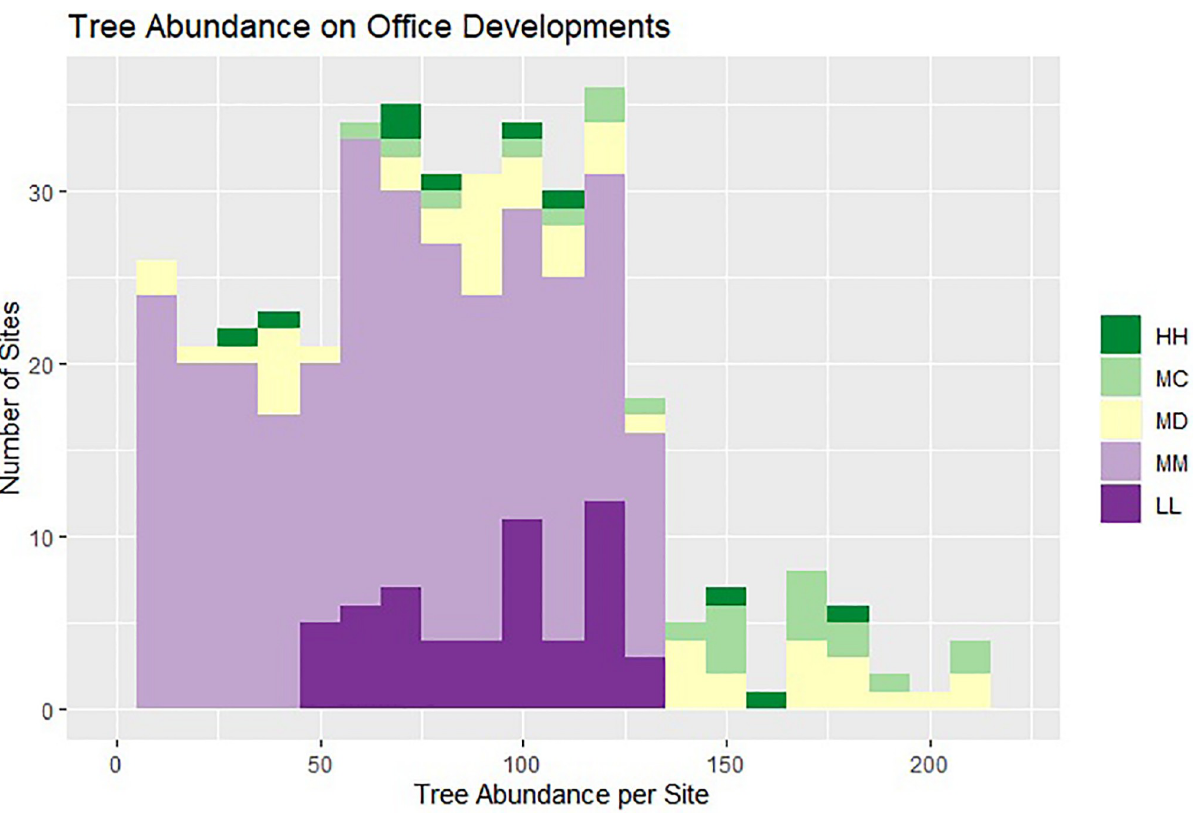
Fig 5. Hypothesized distribution of the number of trees on office developments based on observed mean and standard deviations for each vegetation class used in sampling (HH, MC, MD, MM, LL). Note heavy right tail from HH,MC, and MD sites (kurtosis); each vegetation class also has a different variance